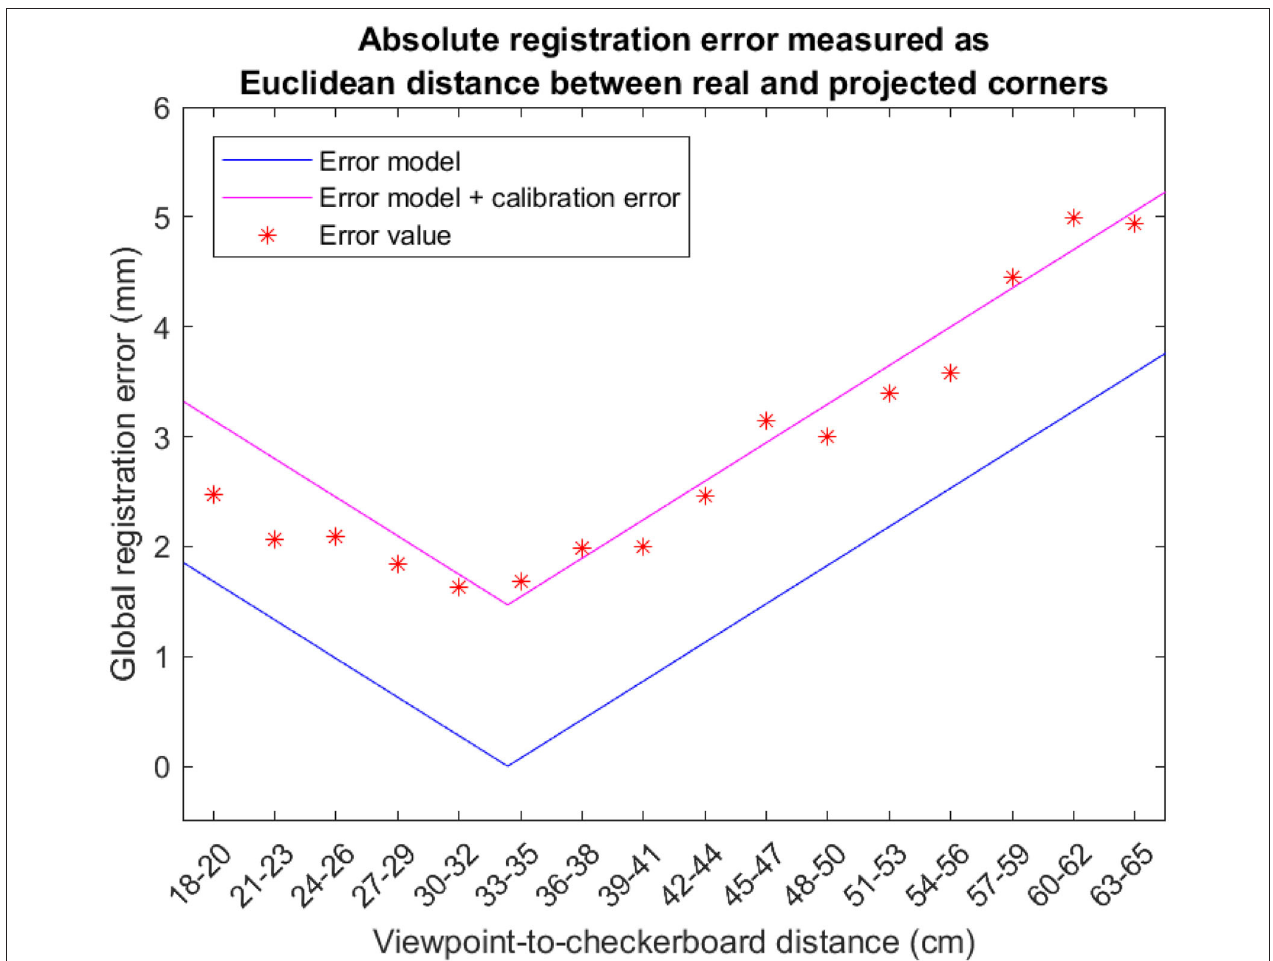
FIGURE 10 | Absolute registration error for the 16 clusters associated with the 16 positions where the validation checkerboard was placed (i.e., for 18 ≤ d C → π ≤ 65 cm). Each asterisk is the average of the absolute registration error computed over the eight viewpoint positions. The lines represent the theoretical registration error due to the viewpoint shift as calculated through the Equation (17). As predicted by our model, the minimum of the curve representing the experimental tests is extremely close to the value of the display focal distance (i.e., ≈ 33cm).